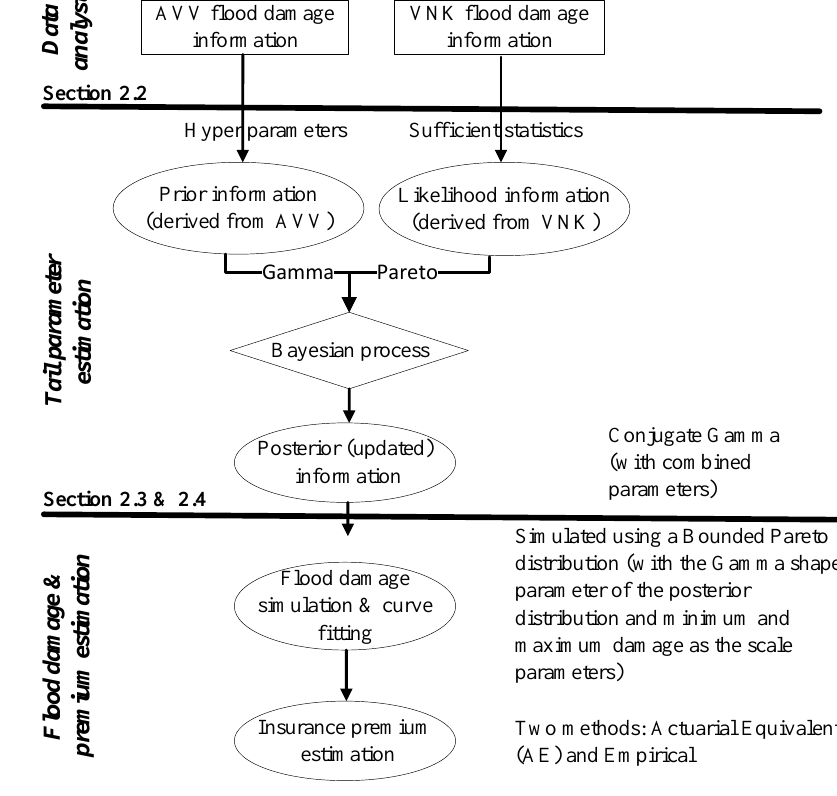
Figure 1: Conceptual model of the overall research methodology Fig. 1. Conceptual model of the overall research